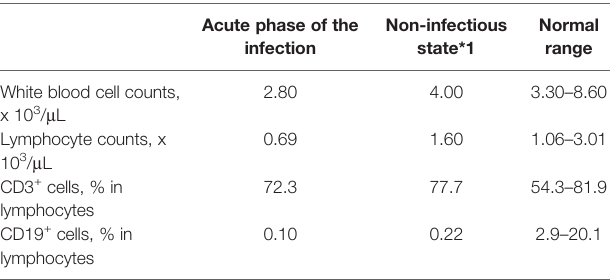
TABLE 1 | The analysis of lymphocyte subsets in the acute phase of cryptococcosis and the non-infectious state. Acute phase of the Non-infectious infection